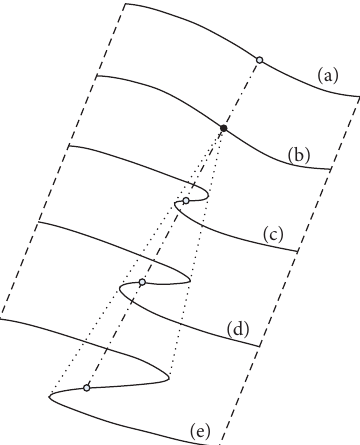
Figure 5: Cross-sectional curve diagram of critical equilibrium